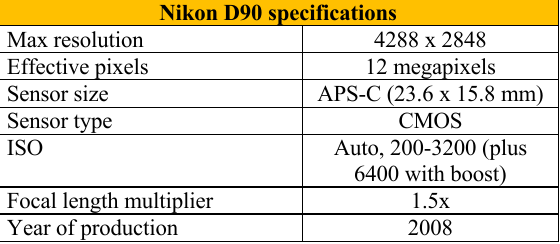
Table 1. Nikon D90 camera specifications.